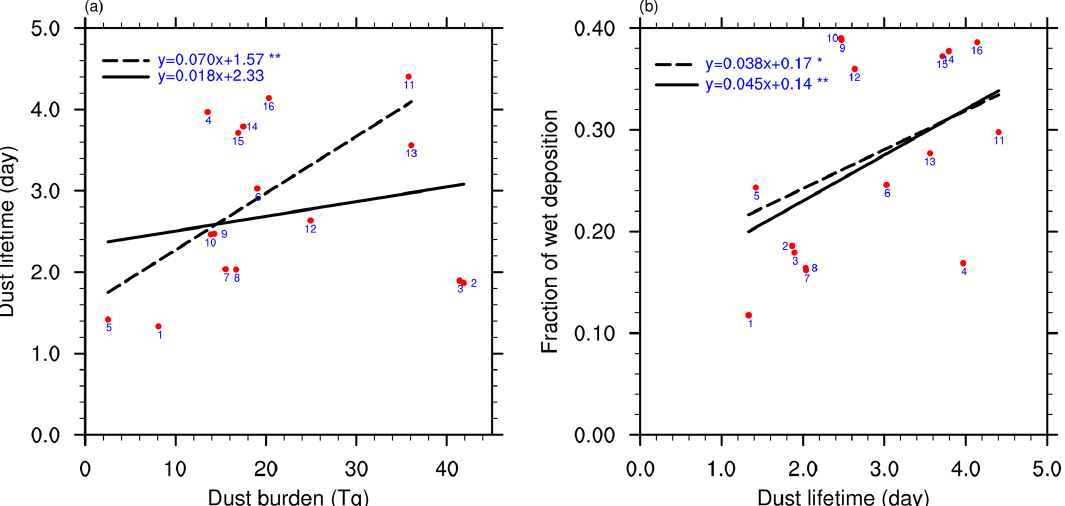
Figure 2. Scatter plot of (a) dust burden versus dust lifetime and (b) dust lifetime versus the fraction of wet deposition to total deposition in 15 CMIP5 models and in the MERRA-2 reanalysis. The models are indexed in Table 1. The regression lines from all the CMIP5 models (solid) and the CMIP5 models excluding HadGEM2-CC and HadGEM2-ES (dashed) are also shown with the slopes and intercepts for the regression equation. The significance test for each regression is denoted by one asterisk ( ∗ ; above significant level of 0.1) or two asterisks ( ∗∗ ; above significant level of 0.05) after each regression